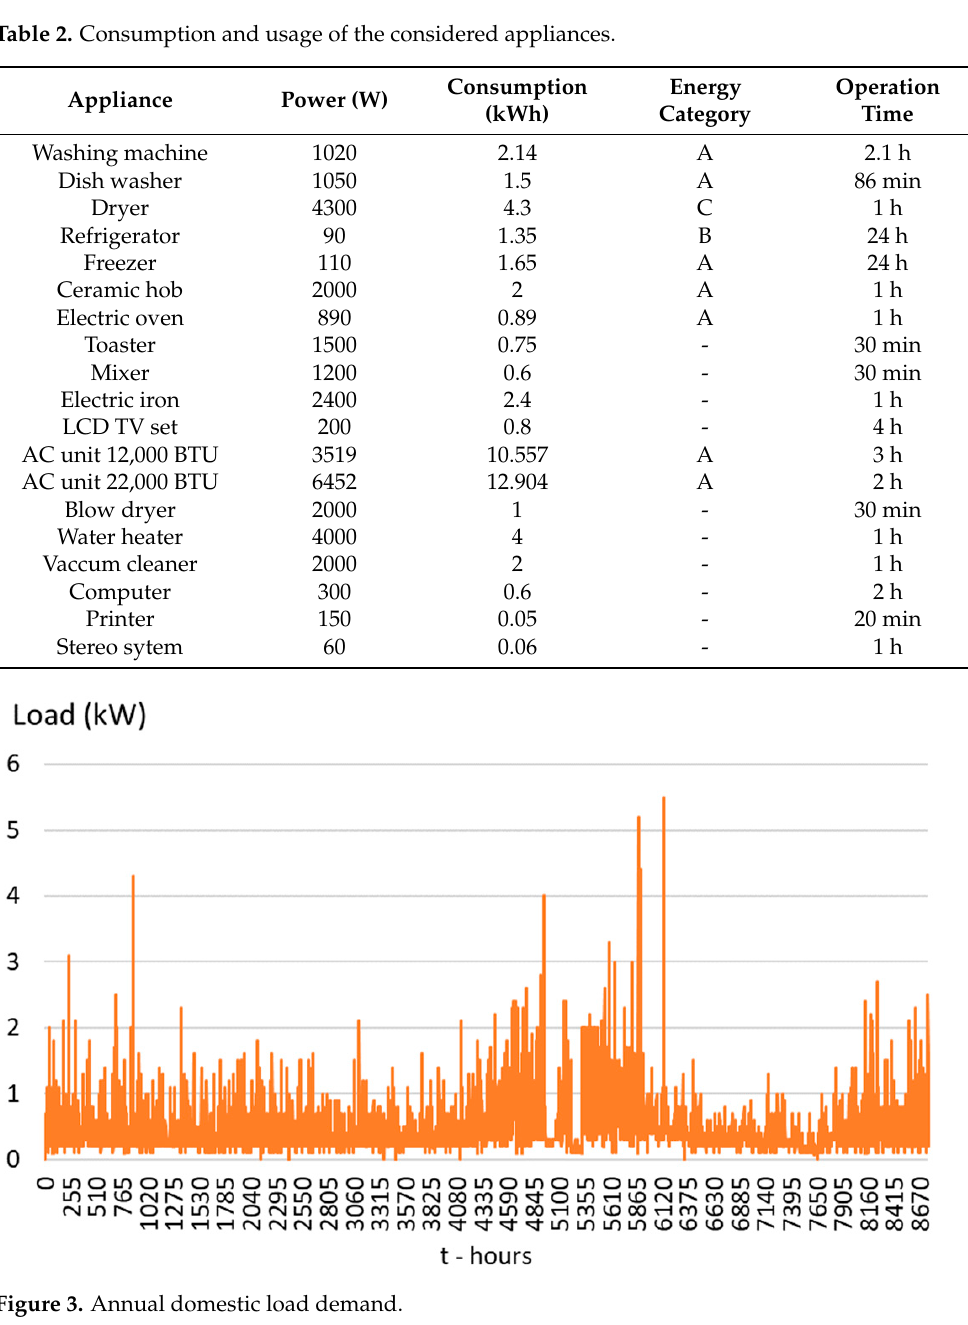
Table 2. Consumption and usage of the considered appliances.